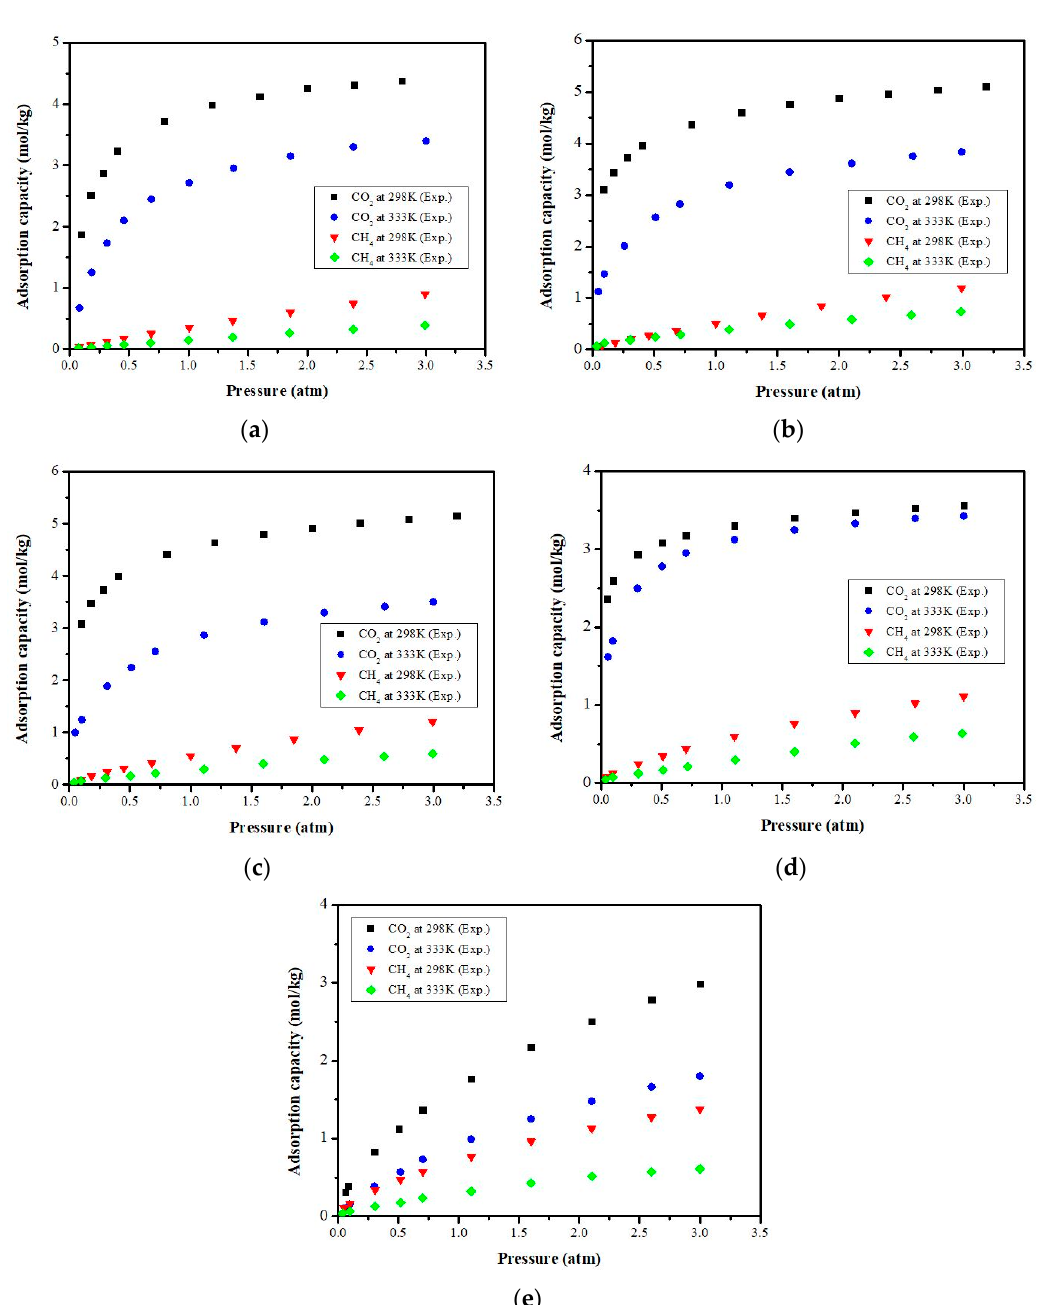
Figure 6. Equilibrium adsorption of pure CO 2 and CH 4 at 298 K and 333 K on ( a ) COSMO zeolite 13X, ( b ) UOP zeolite 13X, ( c ) EIKME zeolite 13X, ( d ) COSMO zeolite 5A, and ( e ) activated carbon. ■ , CO 2 at 298 K; ● , CO 2 at 333 K; ▼ , CH 4 at 298 K; ◆ , CH 4 at 333 K. Table 8. Equilibrium selectivity ( 𝛼 ), working capacities selectivity ratio (W), and selection parame- ter ( 𝑆 ) of different adsorbents at 298 K and 333 K.